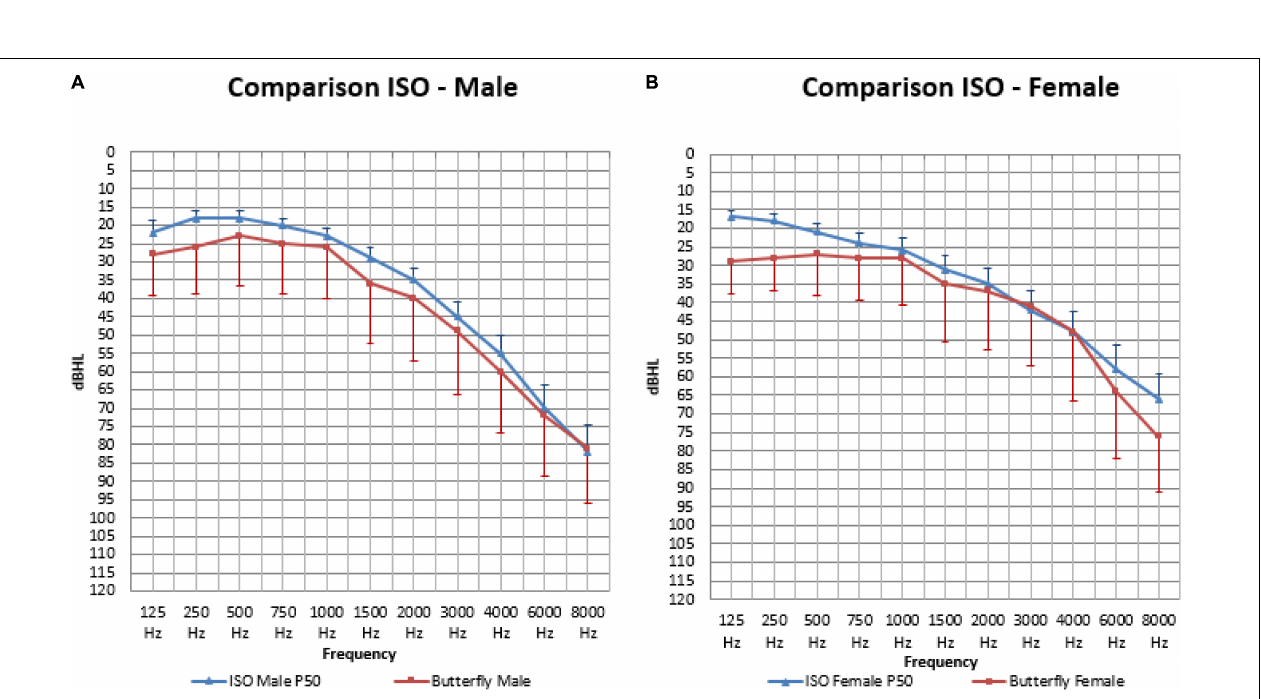
FIGURE 7 | The mean air-conduction thresholds (dB HL) in the better hearing ear for males (A) and females (B) , compared to the standard ISO median value calculated for every participant based on their sex and age for frequencies from 125 Hz to 8,000 Hz.